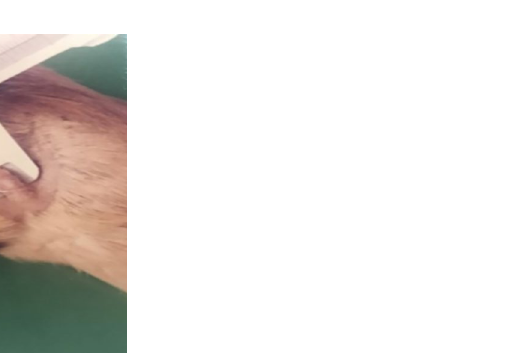
Figure 3. Illustrative chart of a single dermatophyte species based-Trichophytin skin test in Guinea pigs vaccinated with the living, inactivated non-adjuvanted polyvalent dermatophyte vaccines, and the control unimmunized group. Tuberculin test was done using Mycobacterium bovis purified protein derivatives (PPD) as non-specific antigen and NaCl 0.9% was used as negative control.